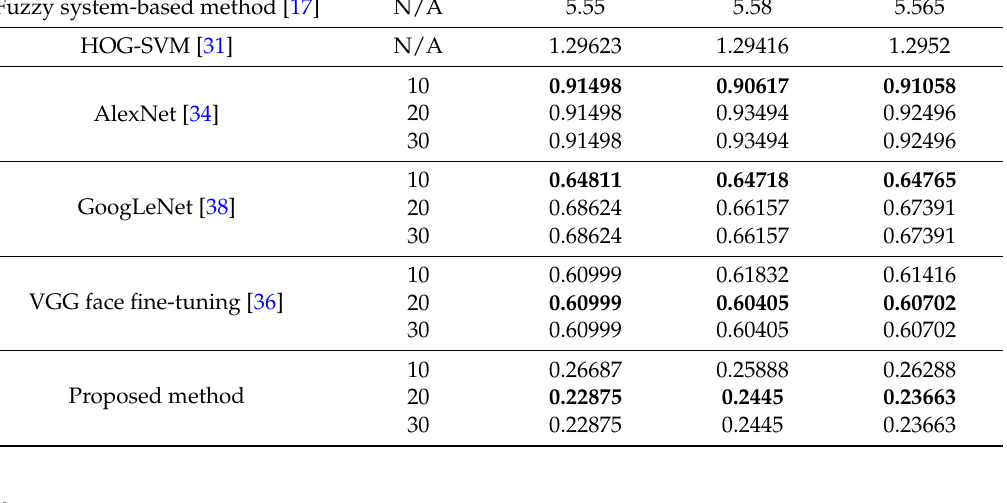
Table 6. Comparative testing errors for our method and other methods (unit: %).